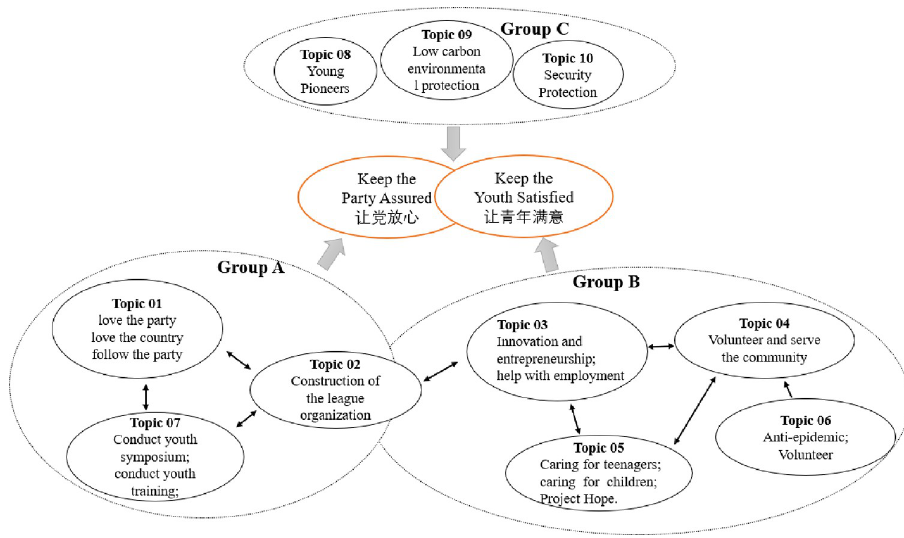
Fig 5. Topic grouping